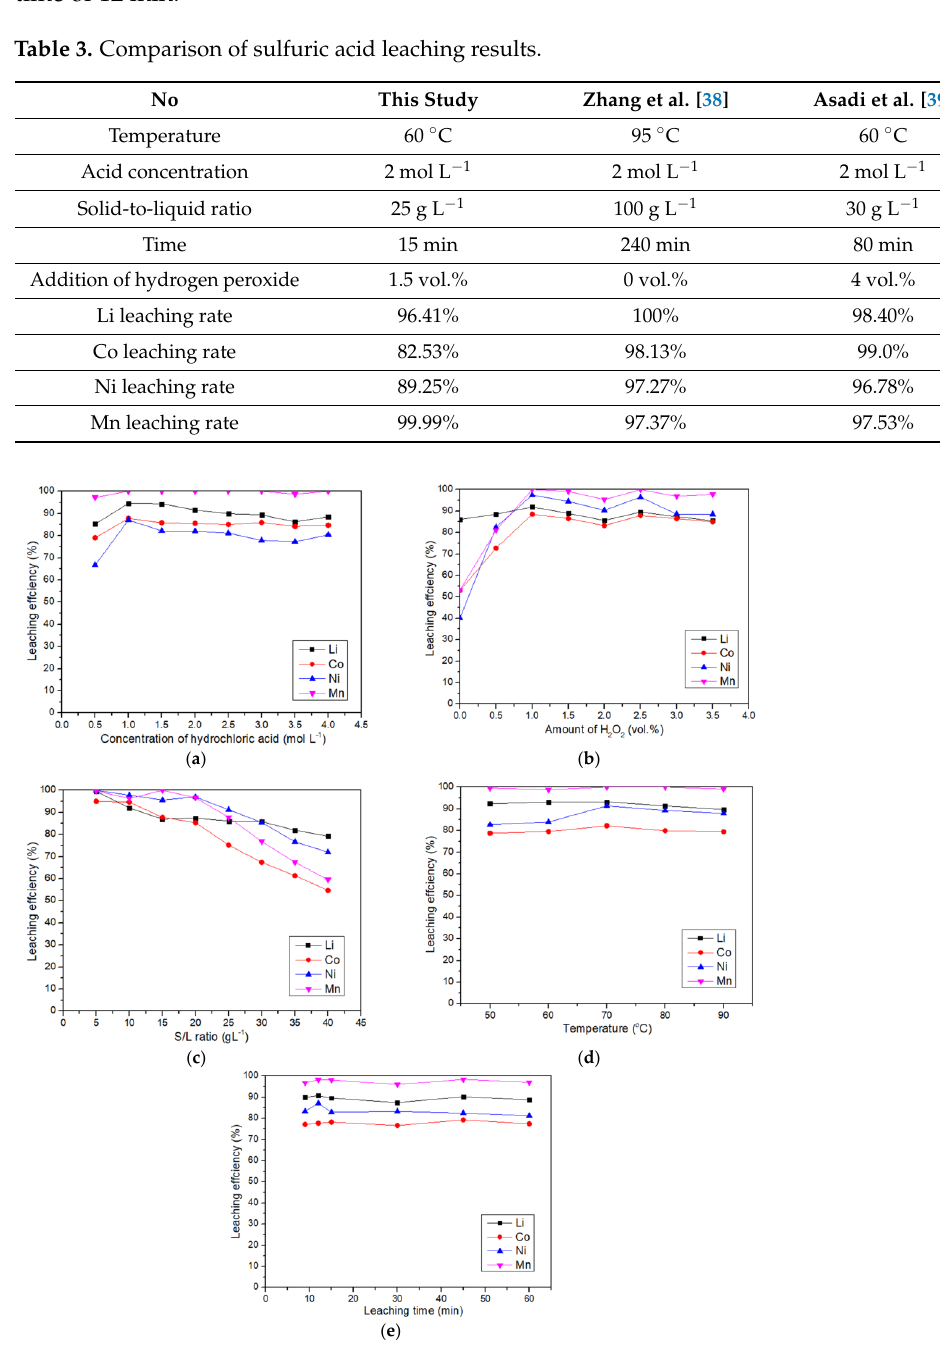
Table 4. Comparison of hydrochloric acid leaching results.